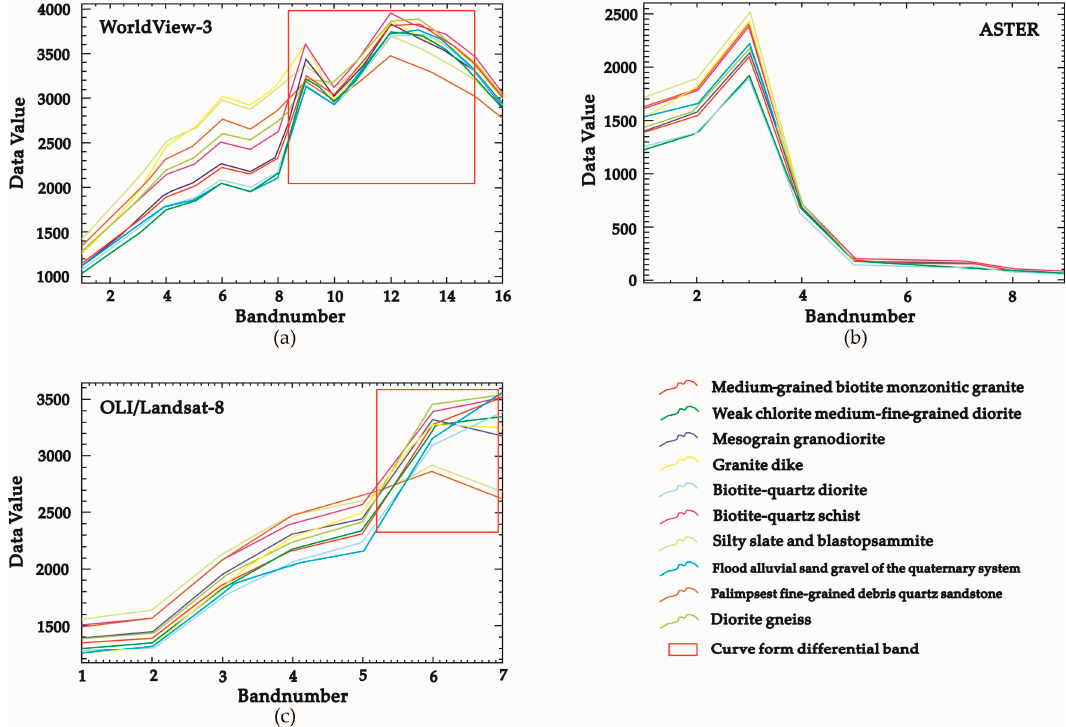
Figure 7. The average spectral curve of each class obtained from WorldView-3, ASTER, and OLI/landsat-8 data, respectively. ( a ) WorldView-3’s average spectral curve; ( b ) ASTER’s average spectral curve; and ( c ) OLI/Landsat-8’s average spectral curve.